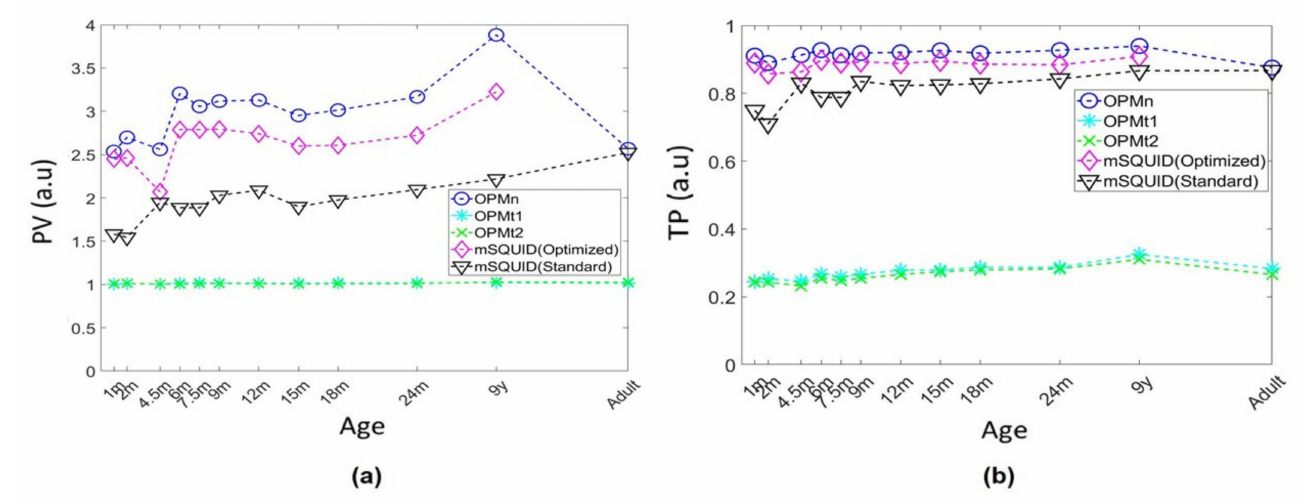
Figure 7. ( a ) The norm ratios between primary and volume current topographies (PV) and ( b ) between total and primary current topographies (TP) for all sensors, by subject age.